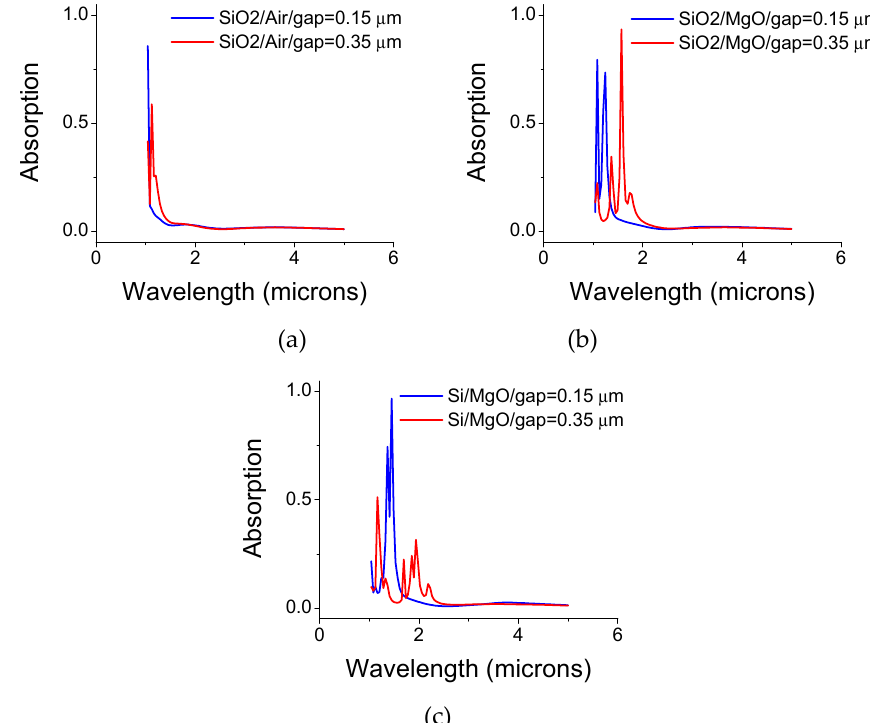
Figure 6. ( a ) Silica sphere in air filled gap, and ( b ) silica spheres embedded in MgO filled gap for two gap values: 0.15 and 0.35 microns. ( c ) Si spheres embedded in MgO filled